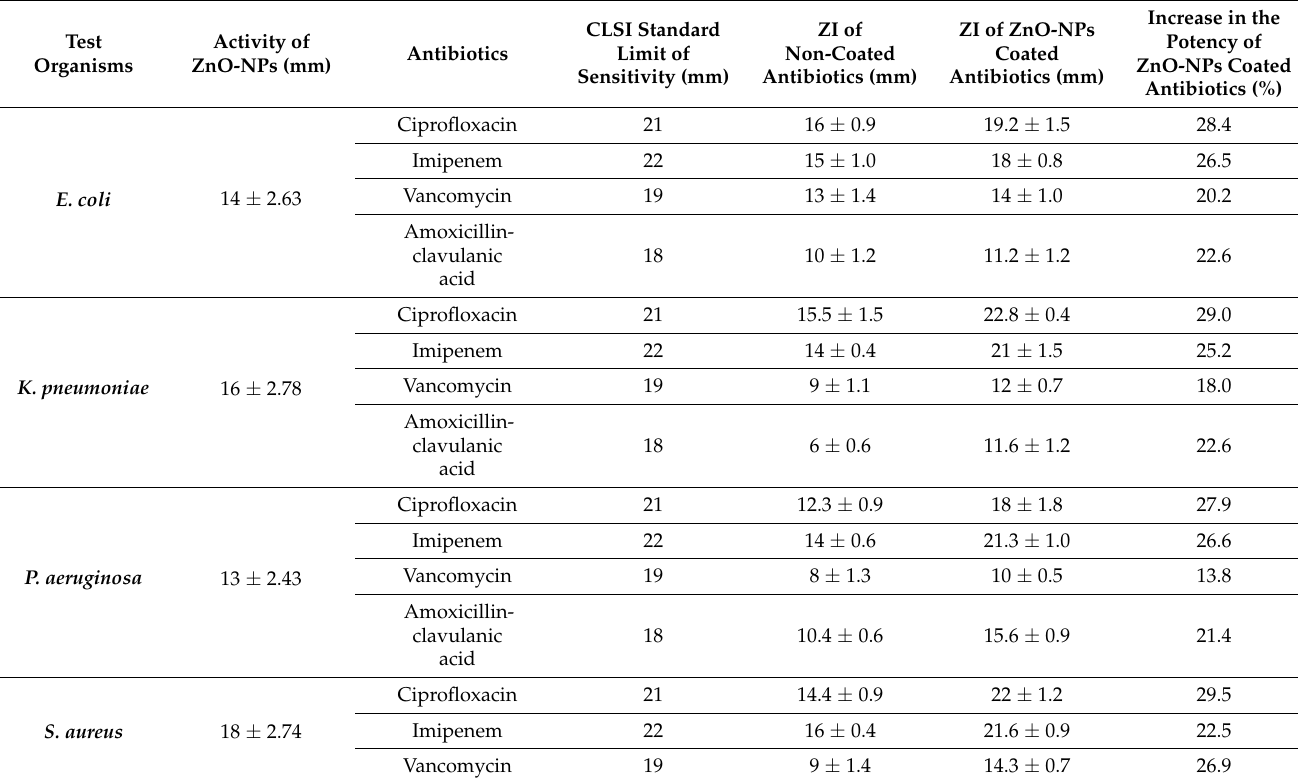
Table 1. Antibacterial Activity of Monotheca buxifolia synthesized